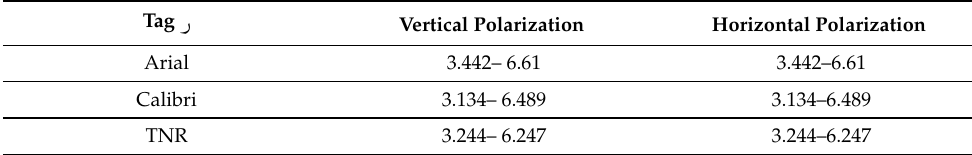
Table 3. Signature resonance frequencies for letter (cid:80) tag with various font types (Arial, Calibri, and Times New Roman) with the font size of 28.